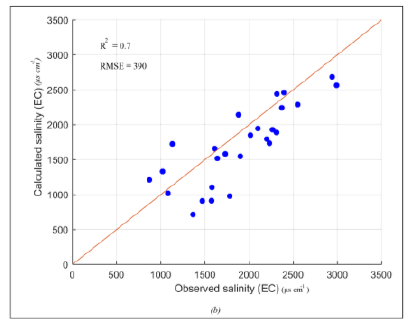
Figure 5. Relation plot of the calculated salinity vs. measured ones (test